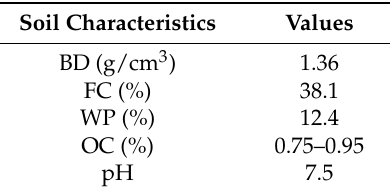
Figure 1. The location of experiment station. Table 1. Characteristics of the soil in the study area.